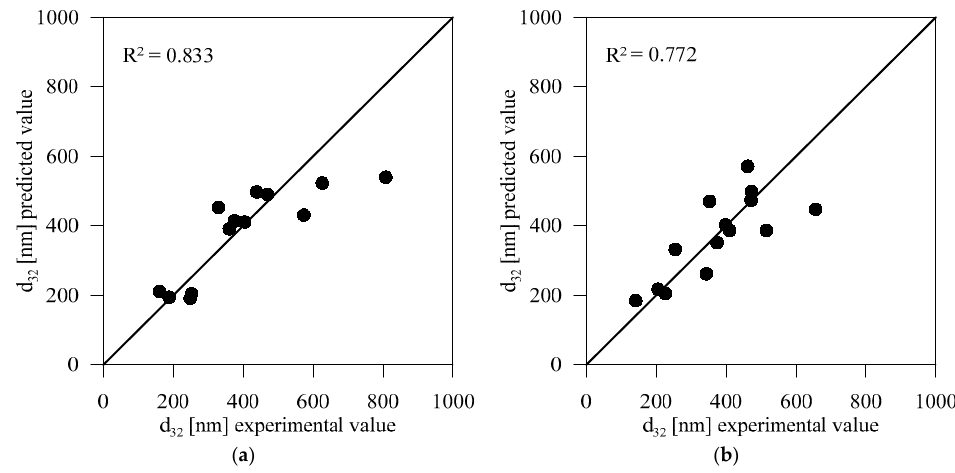
Figure 4. Parity plots for power models ( a ) power model for oxygen bubbles, ( b ) power model for hydrogen bubbles.